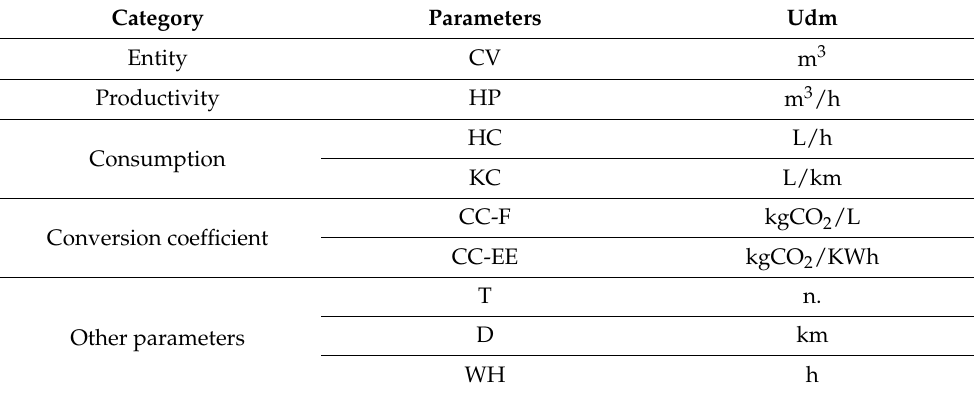
Table 3. Main parameters, abbreviations and units of measure used in the emissions